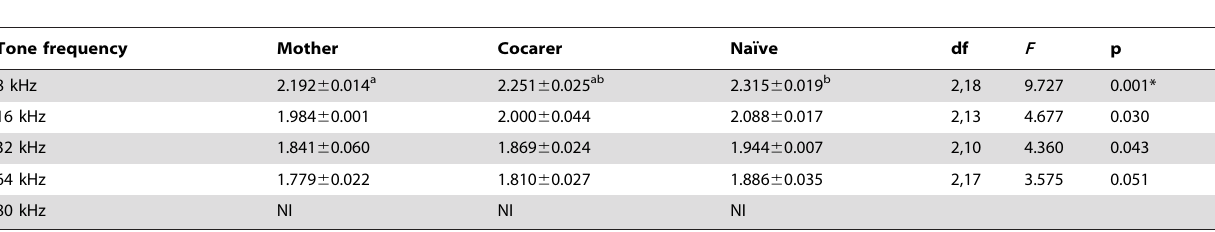
Table 3. Tone-evoked peak I ABR latencies measured 10 dB above each animal’s threshold.